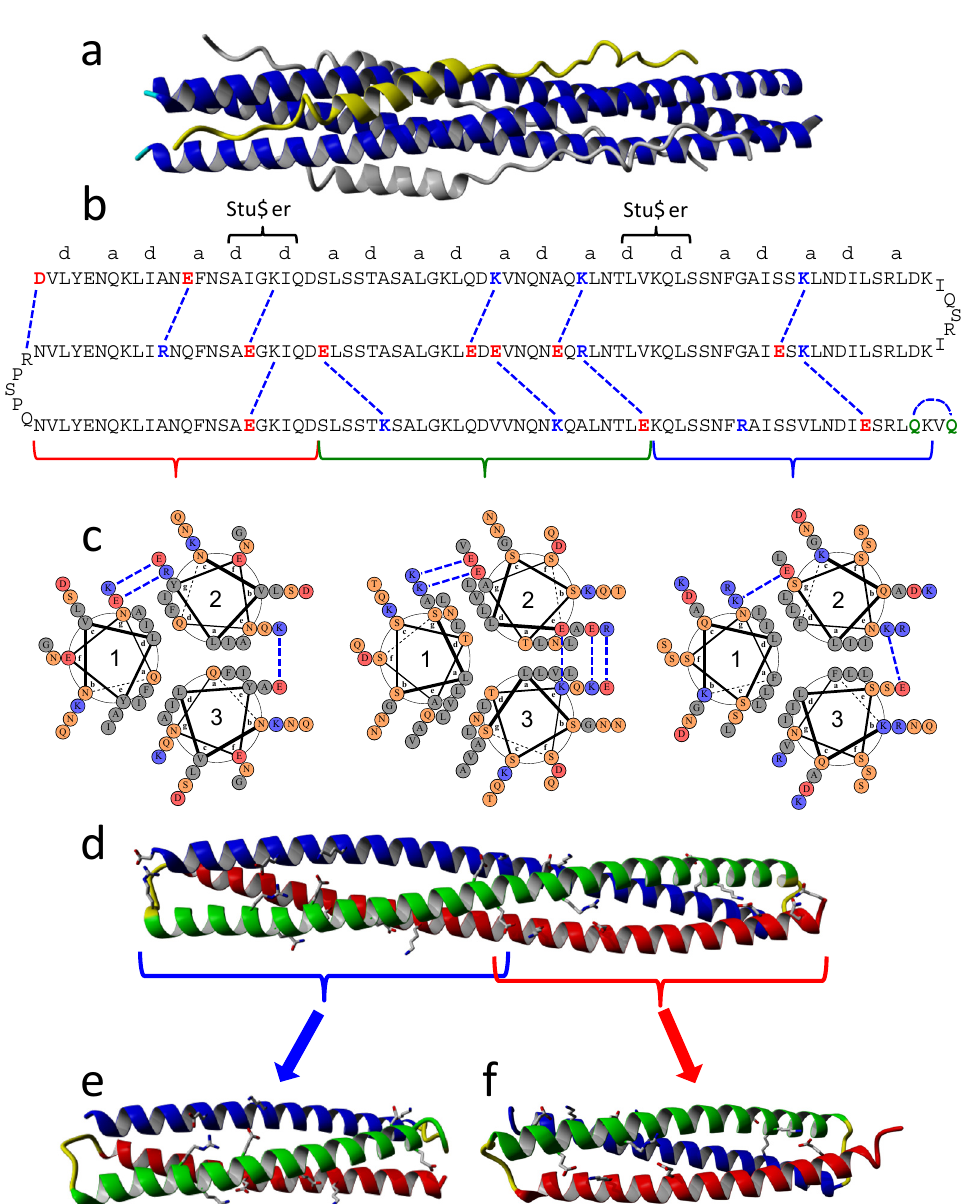
Figure 2. Design of CoVS-HR1 proteins. ( a ) Structure of the core post-fusion complex between HR1 and HR2 (PDB id. 6LXT [18]) used as a design template. The three central HR1 helices are represented in blue, and the three external HR2 regions are indicated in grey and yellow. ( b ) Sequence and topology of the L1 variant indicating the engineered amino acid substitutions (highlighted with colors) and the stabilizing interactions (with blue dashed lines). The ‘a’ and ‘d’ characters on top of the first sequence stretch indicate the corresponding positions in the HR1 heptad repeat. Two stutters in the canonical repeats are indicated. ( c ) Helix-wheel diagrams corresponding to sections of the coiled coils are indicated with brackets under ( b ). The diagrams were generated with Drawcoil (https://grigoryanlab.org/drawcoil/, accessed on 2 June 2022). The blue dashed lines indicate the engineered stabilizing interactions in each molecule. ( d ) Ribbon representation of the model of the full-length HR1-mimetic proteins (CoVS-HR1-L1 and CoVS-HR1-L2). The parallel HR1 helices 1 and 3 are indicated in blue and red, respectively, and the reversed helix 2 is indicated in green. The loops connecting the helices are colored yellow. The side chains of amino acids engineered to stabilize the antiparallel fold are represented by sticks. ( e , f ) Ribbon models of the shortened CoVS-HR1-N ( e ) and CoVS-HR1-C miniproteins ( f ).